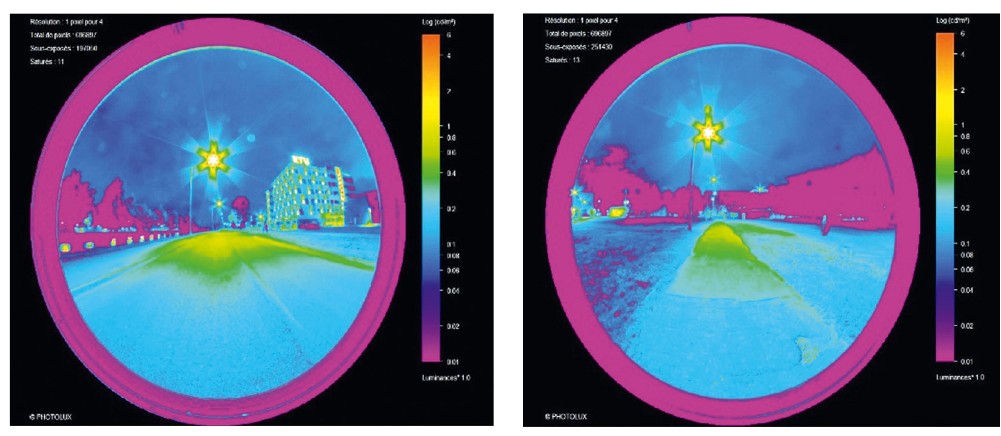
Figure 12. LITES PilotSite: Dialux simulation results (a), Measurements of LED 95W luminary (b) and